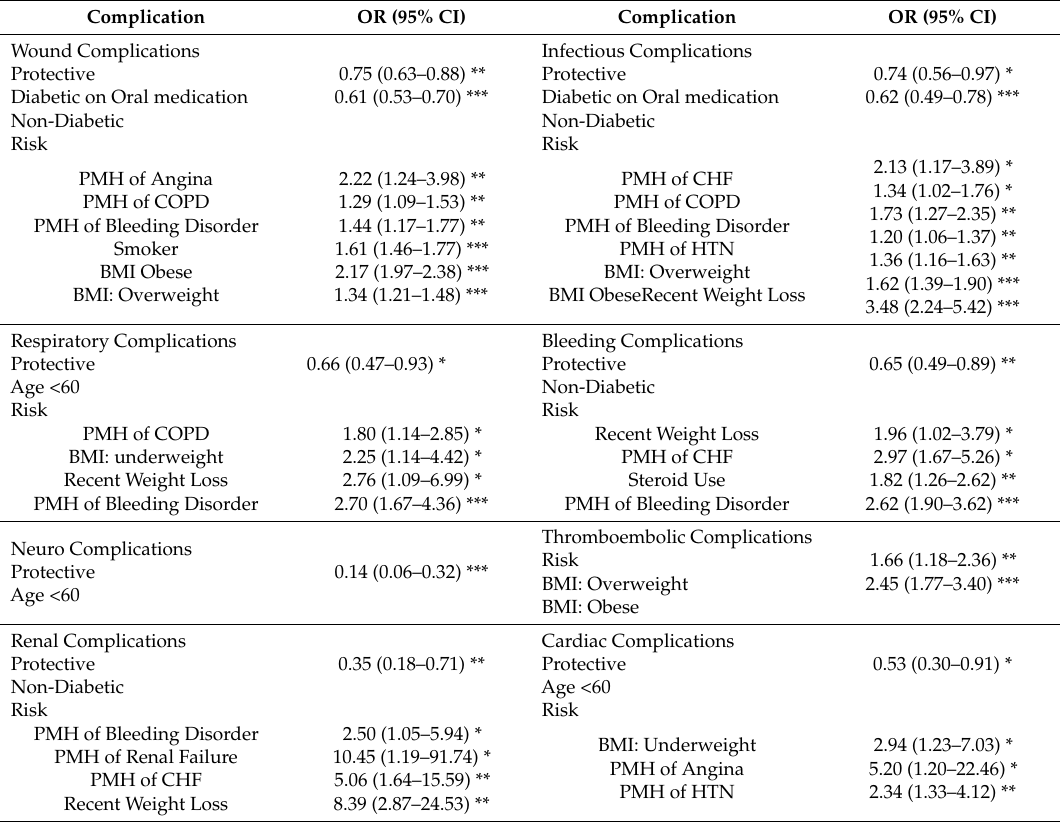
Table 6. Multivariable Logistical Regression Analysis of 30-Day Complication Rate: Patient Characteristics and Demographic